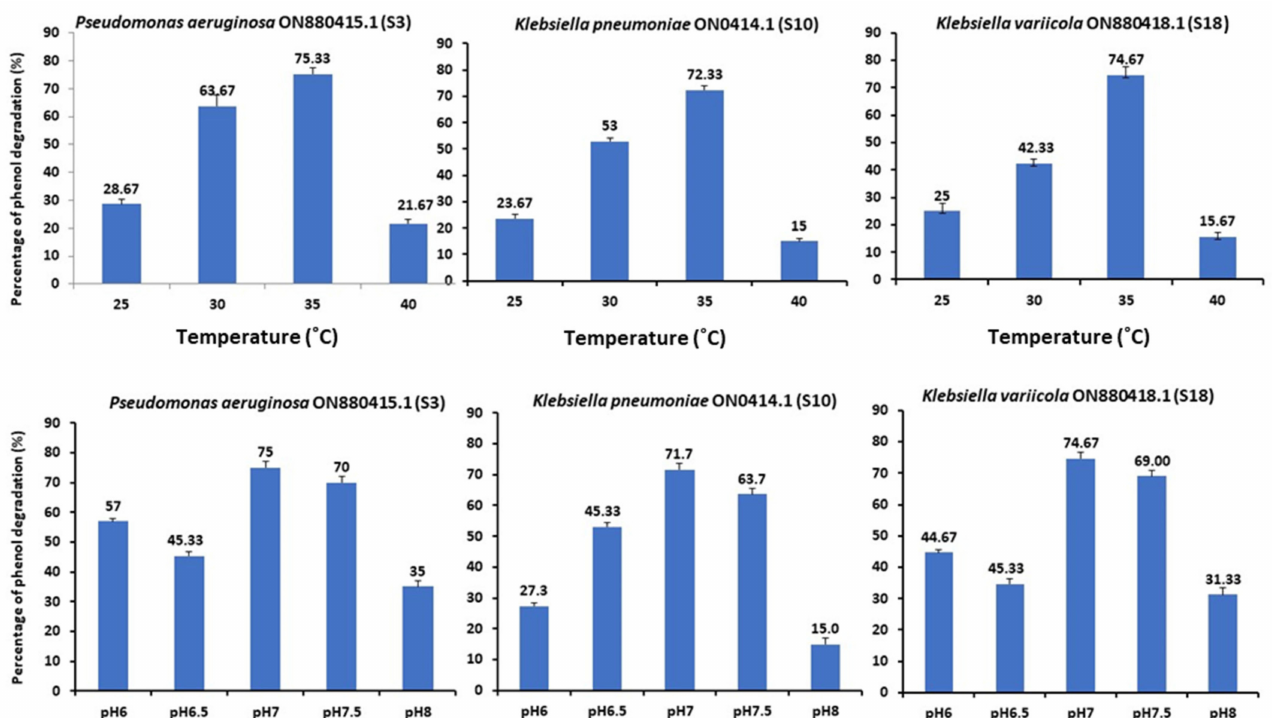
Figure 5. Effect of pH and temperature on phenol biodegradation by Pseudomonas aeruginosa (S3), Klebsiella pneumoniae (S10), and Klebsiella variicola (S18) (initial phenol concentration was 1000